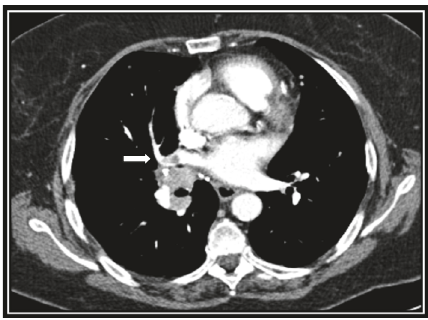
Figure 2: PET-FDG computed tomography scan performed 6 months after surgery and radioiodone ablation. The right superior pulmonary vein appears occluded by a thrombus